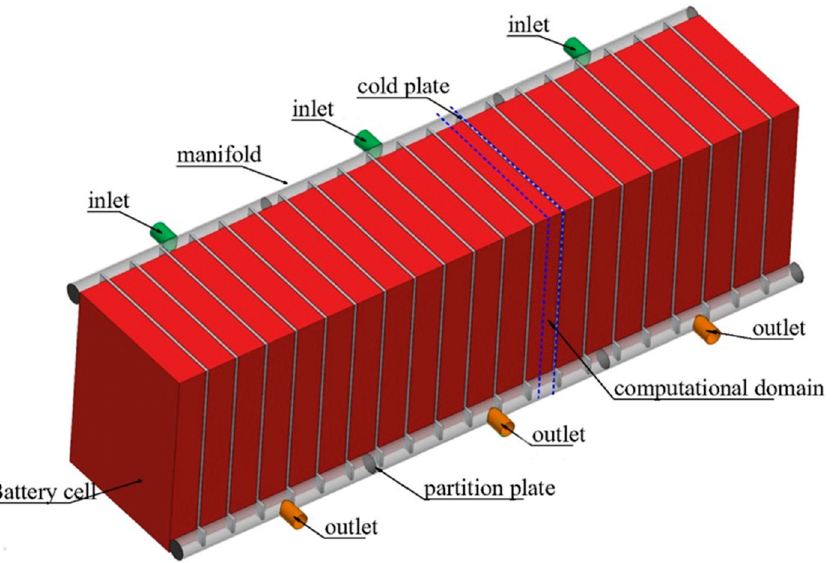
Table 1. Main performance parameters and thermo-physical properties of the ba tt ery, coolant, and cold plate explored in this study.